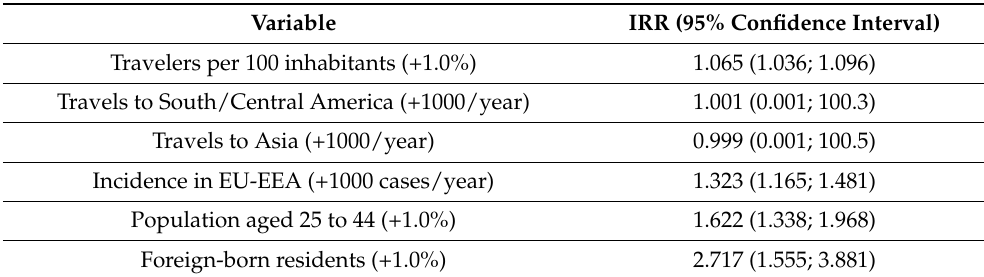
Table 4. Incidence rate ratios (IRR) for dengue cases in Italy (2010–2020) by demographics and main characteristics of the index cases. IRR were calculated by means of a Poisson logistic regression assuming as outcome variable the annual incident cases of dengue. Variable IRR (95% Confidence Interval) Travelers per 100 inhabitants (+1.0%) 1.065 (1.036; 1.096) Travels to South/Central America (+1000/year) 1.001 (0.001; 100.3) Travels to Asia (+1000/year) Incidence in EU-EEA (+1000